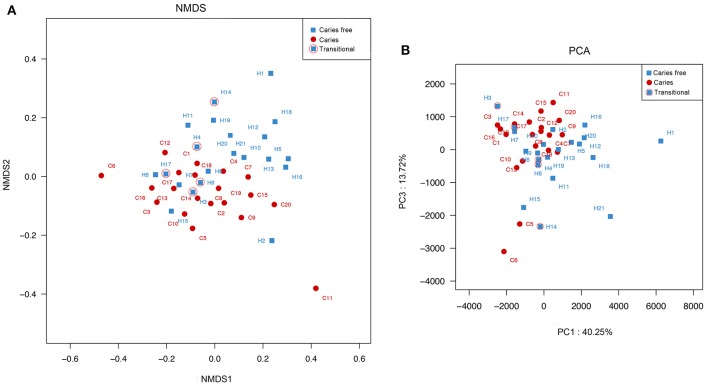
(A) Principle Component Analysis among caries and caries free children was based on euclidean metric distance. (B) Principal co-ordinates analysis between the two groups was based on other similarity measures. Each symbol represented a sample.